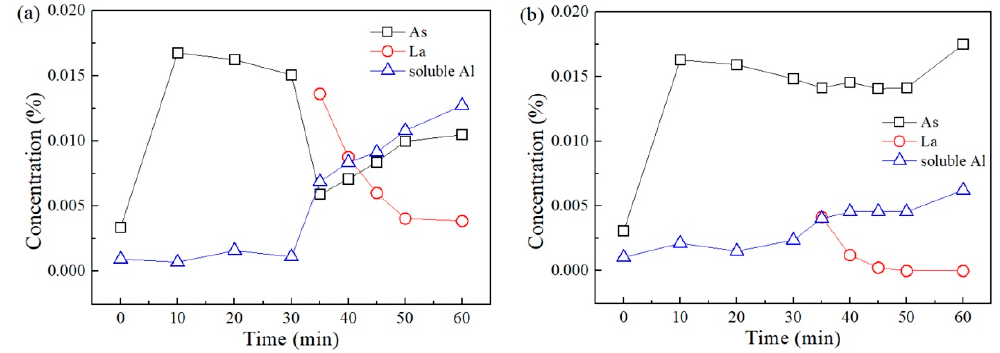
Figure 3. Changes in concentrations of As, La, and acid-soluble Al in steel (Arsenic additions were made at 10 min, La additions at 30 min, and the points at 60 min represent the samples taken from ingots). ( a ) the 0.148% La-added steel; ( b ) the 0.054% La-added steel.